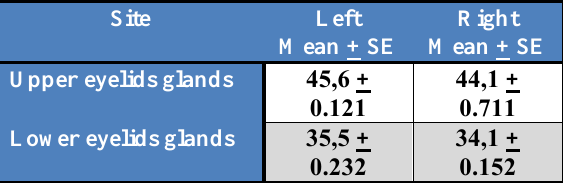
Table, 1: Showing the numbers of meibomian glands in the left and right of upper and lower eyelids in goats.